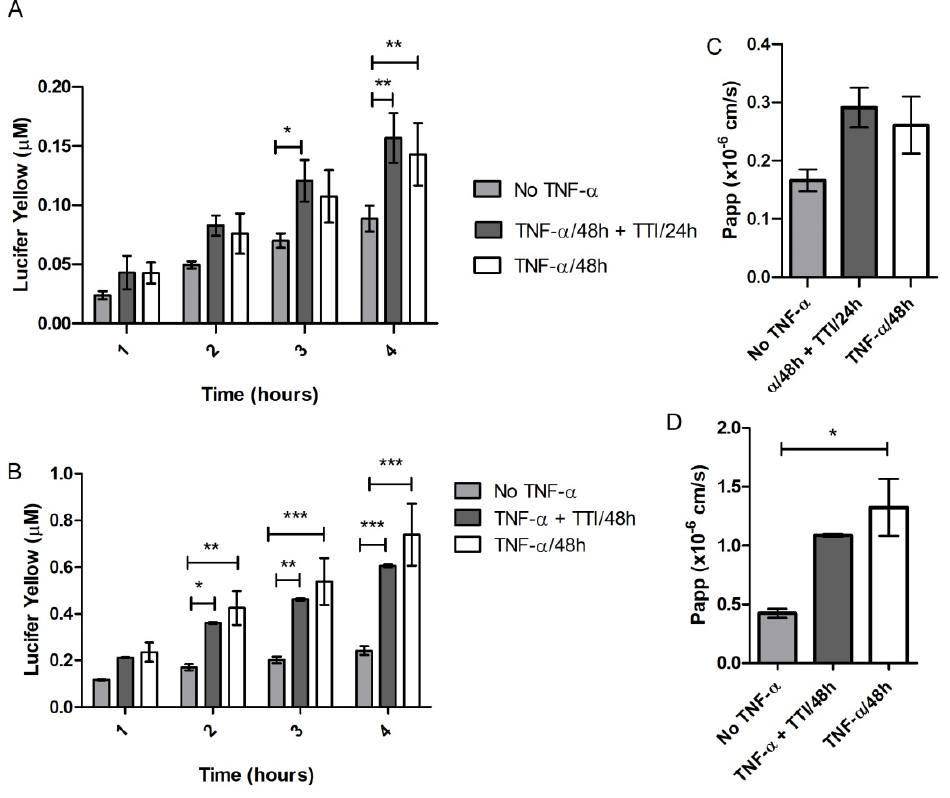
OB/HGLI: no treatment group; OB/Standard: group treated with a nutritionally adequate diet (standard diet Labina ® ); OB/HGLI/TTI: group treated with trypsin inhibitor isolated from tamarind seeds (TTI). * Hematocrit, total leukocyte count, fasting blood glucose and GOT had a non ‐ paramet ‐ ric distribution, so the Kruskall–Wallis test was performed with Dunn’s post ‐ hoc test to verify dif ‐ ferences between the pairs. The other parameters presented a parametric distribution, being per ‐ formed one ‐ way ANOVA test with Tukey’s post ‐ hoc test. Values are presented as mean (standard deviation). Equal lowercase letters on the same line: means did not differ significantly. OB: obesity; Figure 7. Concentration of Lucifer Yellow (LY) permeated to the basolateral side over 4 h ( A , B ) and apparent permeability ( C , D ) in co-cultures of Caco-2:HT29-MTX cells stimulated with TNF- α 50 ng/mL on the basolateral side for 48 h. Treatment with TTI 1.0 mg/mL was performed ( A , C ) after inflammation for 24 h or ( B , D ) during inflammation for 48 h. * p < 0.05; ** p < 0.01; *** p < 0.001; in ( A , B ): two-way ANOVA test with Bonferroni post-hoc test; in ( C , D ): one-way ANOVA test with Bonferroni post-hoc test. Paap: apparent permeability; TTI: trypsin inhibitor isolated from tamarind seeds.